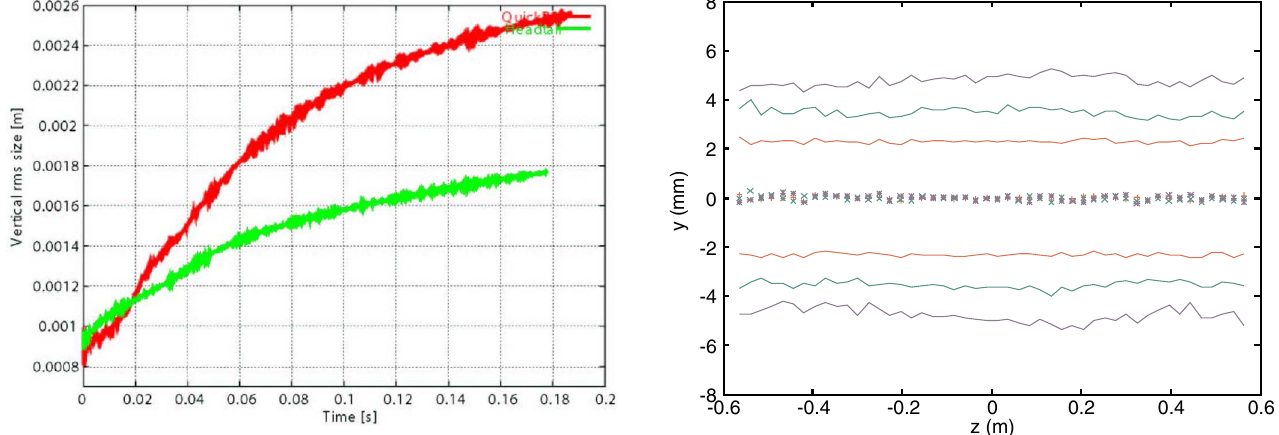
FIG. 50. (Color) Simulated vertical bunch shape (centroid and rms beam size) after 0, 250, and 500 turns in the CERN SPS assuming a cloud density of 10 12 m (cid:2) 3 without proton space charge [53]; the HEADTAIL code was used; the vertical scale extends from (cid:2) 8 to (cid:10) 8 mm , the horizontal axis from (cid:2) 0 : 6 to (cid:10) 0 : 6 m ( (cid:6) 2 (cid:16) ). z